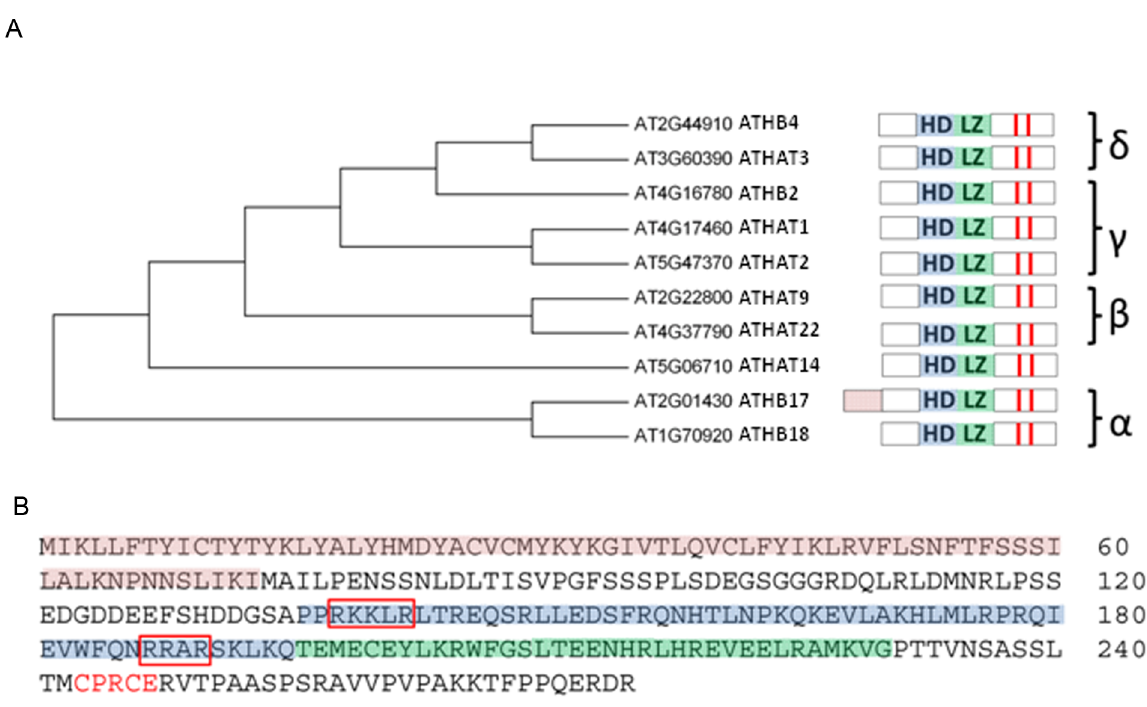
Figure 1. ATHB17 is a member of the a subclass within the HD-Zip II protein family. (A) represents the dendrogram and the domain architecture of the ATHB17 homologs. ATHB17 contains a typical homeodomain (HD; blue shading) and a leucine zipper motif (LZ; green shading) adjacent to the C-terminus of the HD. Red bars indicate conserved cysteines in the C-terminus. (B) shows the protein sequence of ATHB17. ATHB17 contains a unique N-terminal extension (red shading) rich in cysteines and tyrosines. Additional structural feature identified for ATHB17 is a nuclear localization signal (red boxes). Downstream of the LZ motif is a putative redox sensing motif (CPXCE; red letters).